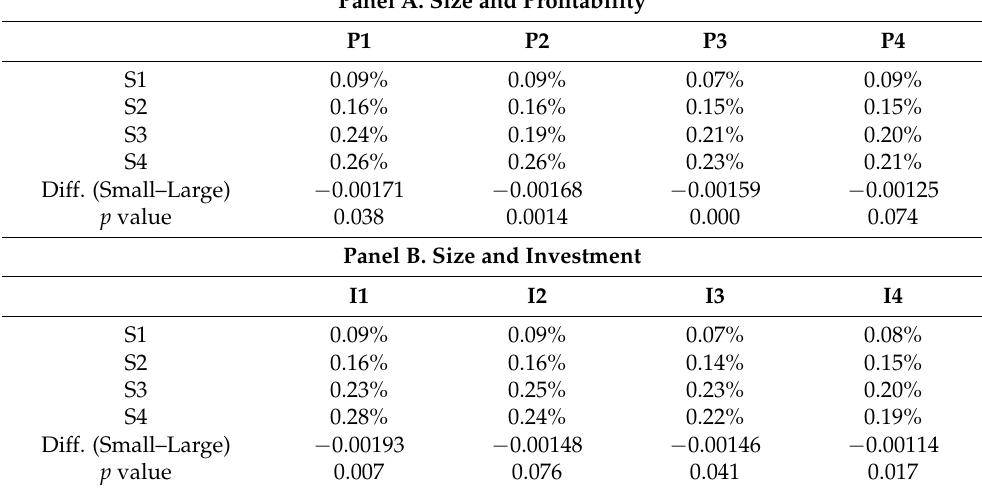
Table 2. Portfolio returns based on size with profitability and investment. The table represents the average returns of 24 portfolios formed oversize and profitability, and 24 portfolios developed oversize and investment. A total of 527 listed firms is analyzed, from which we dropped firms with negative book-to-market equity. Firms with missing values and no data were dropped. S1 to S4 represents small to large portfolio stocks, I1 to I4 represents conservative to aggressive investment stocks, and P1 to P4 represents weak to robust profitability stocks. The difference between small and large portfolios is provided with the p value to measure the significant difference between small and large